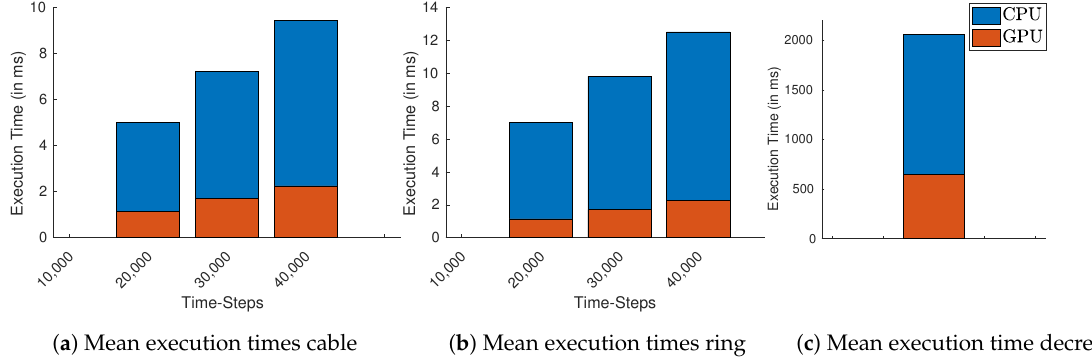
Figure 5. Mean execution times over all cable lengths and resistance values for GPU (orange) and CPU (blue). ( a ) Cable, ( b ) ring, and ( c ) decreasing ring